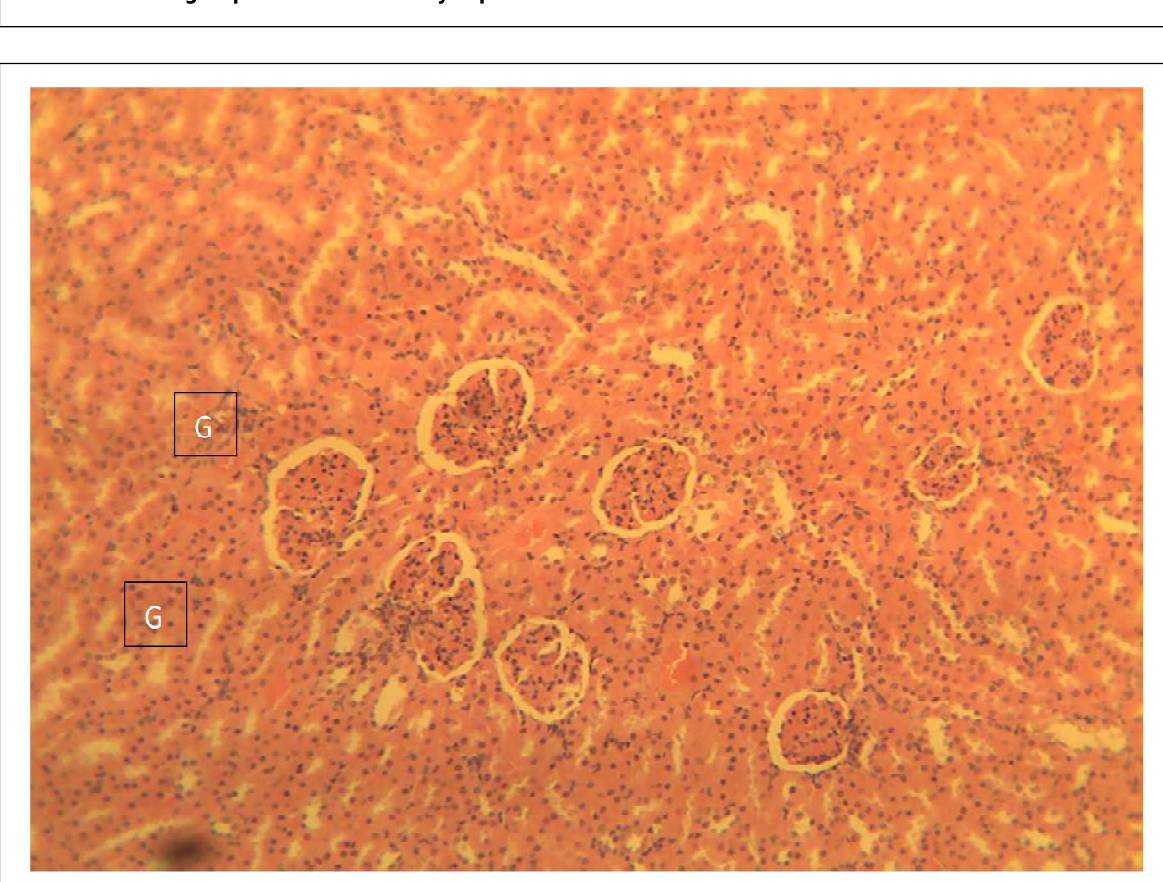
Plate 7: Male kidney of the group exposed to 200 mg/kg of aqueous